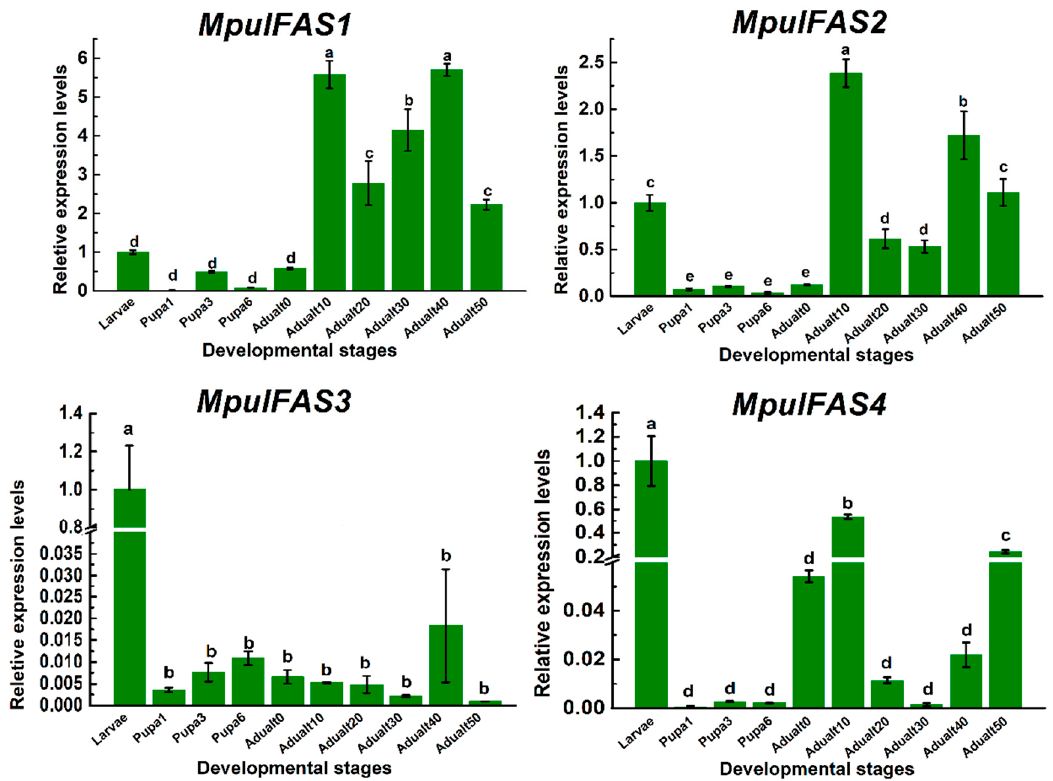
Figure 4. Relative mRNA expression levels of MpulFASs at different developmental stages. The relative expression level was calculated using the 2 −ΔΔ Ct method. A one-way analysis of variance (ANOVA) with Tukey’s post-hoc test was used to check for significant differences in the expression levels of each target gene among the treatments. The different lowercase letters above the bars indicate groups with significant differences ( p < 0.05).